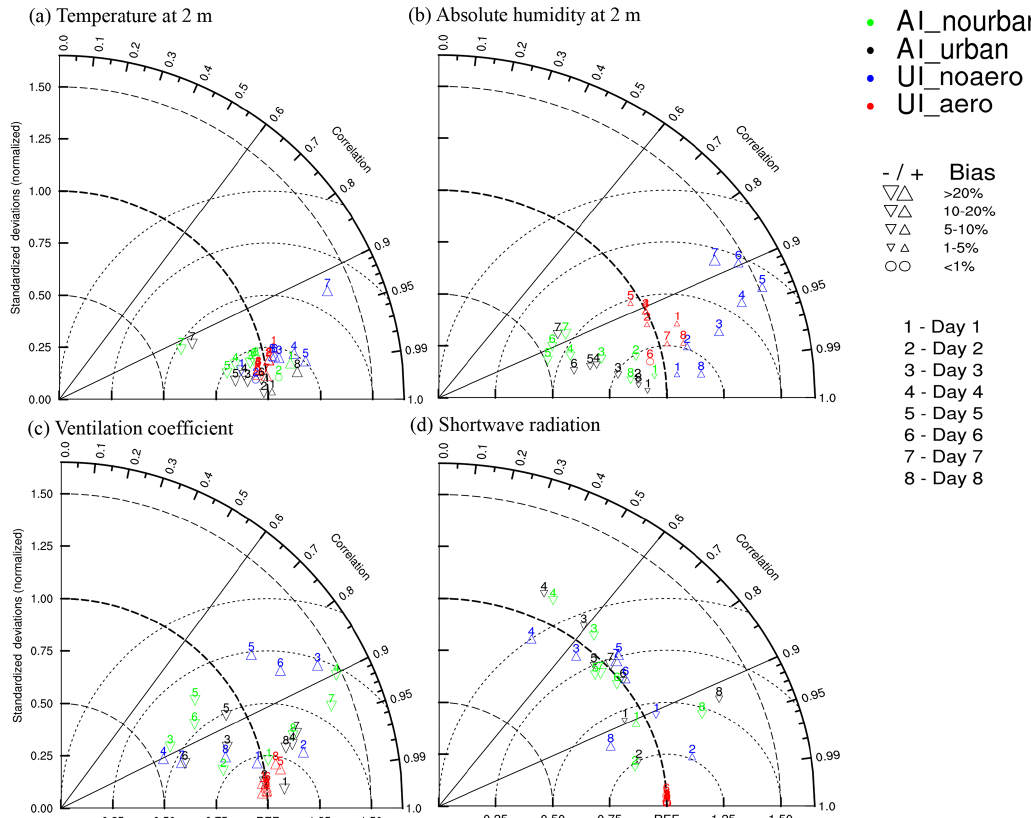
Figure 9. Daily means of the four types of impacts (UI_aero, UI_noaero, AI_urban, and AI_nourban) in the 8d are shown in Taylor diagrams in the Beijing area. (a) Temperature at 2m ( ◦ C); (b) absolute humidity (gkg − 1 ); (c) ventilation coefficient (m 2 s − 1 ); (d) shortwave radiation (Wm − 2